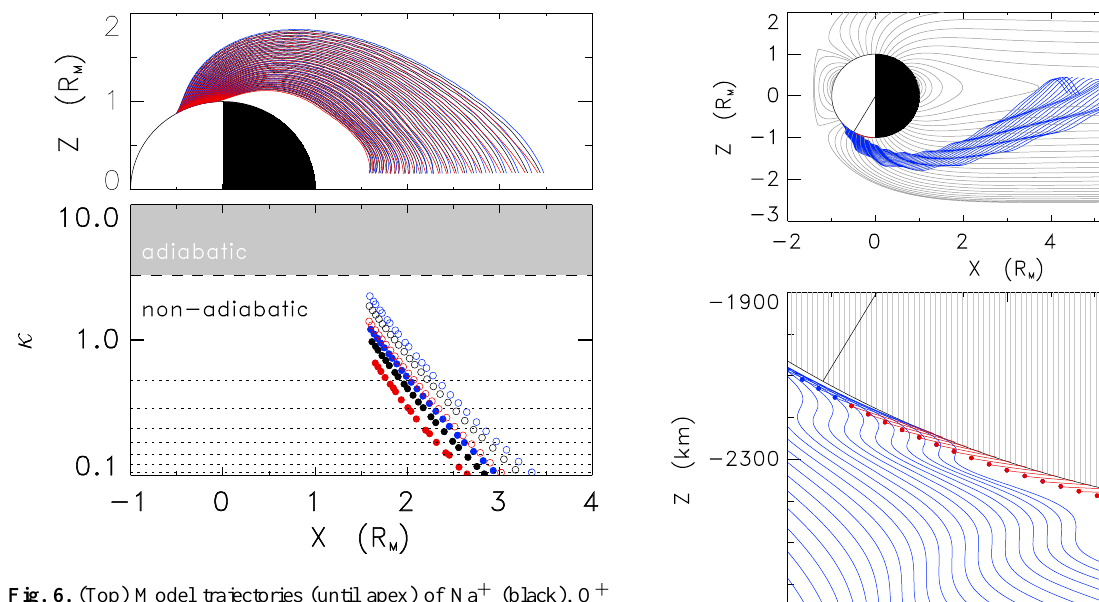
Fig. 6. (Top) Model trajectories (until apex) of Na + (black), O + (blue) and Ca + (red) in the noon-midnight meridian plane. (Bot- tom) κ parameter of the ions at trajectory apex versus distance X . Open and closed circles in the bottom panel show the results ob- tained for 18 = 10kV and 18 = 30kV, respectively. Dotted lines in this panel show the κ values for preferentially transient (Speiser- type) orbits.